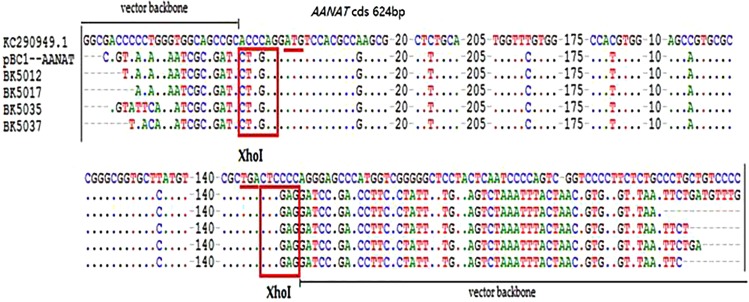
The sequencing detection of transgenic offspring.